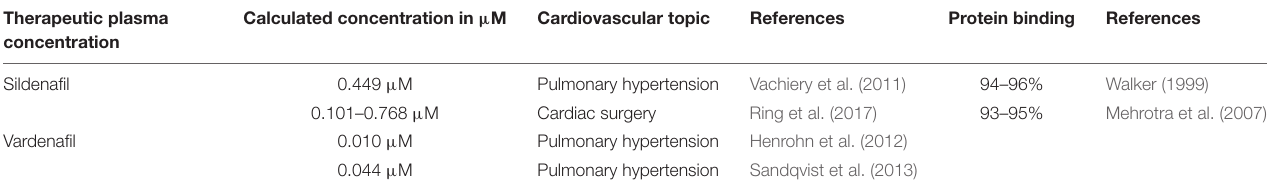
TABLE 1 | Therapeutic plasma concentrations from a literature review of sildenafil and vardenafil, administered for cardiovascular support. Therapeutic plasma concentration